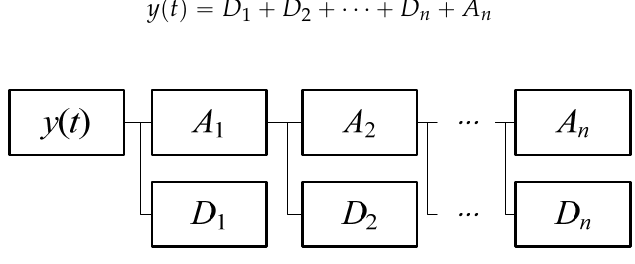
Figure 2. Schematic diagram of the wavelet transform signal analysis.